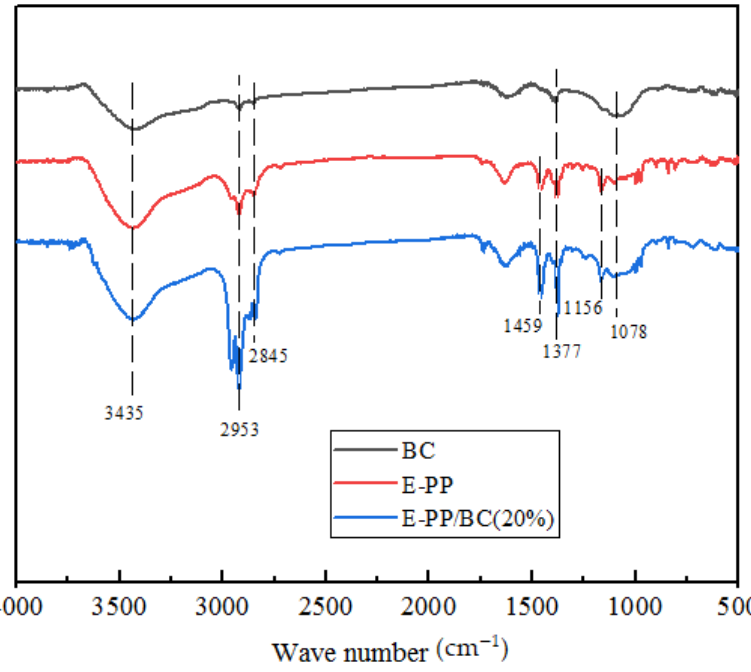
Figure 4. FTIR spectra of BC, E-PP, and the E-PP/BC (20 wt.%) composite.